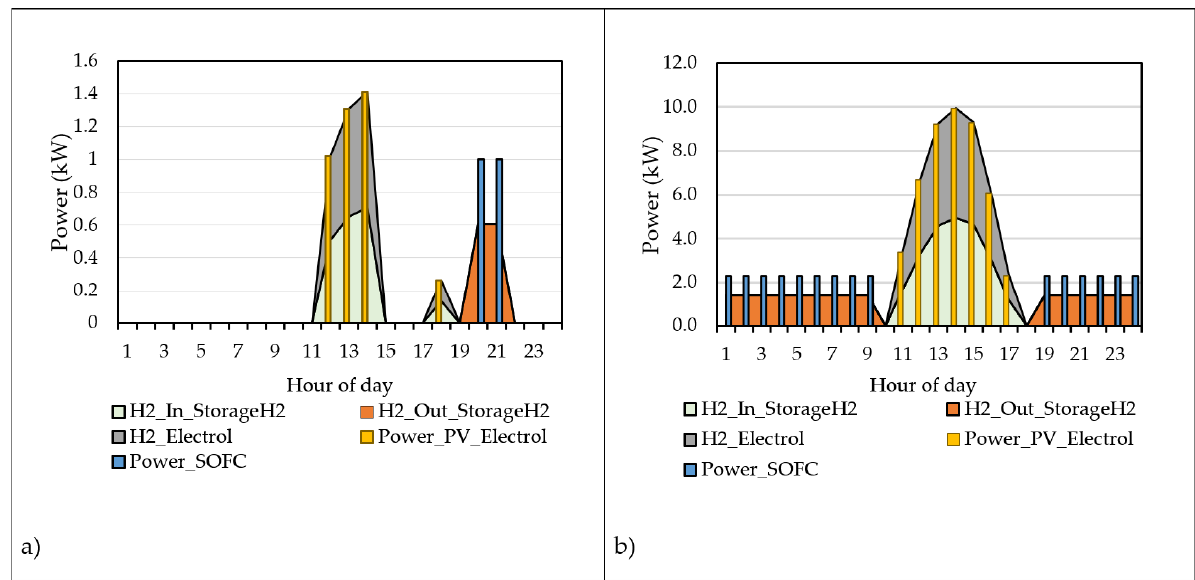
Figure 7. Hourly operation strategies of the r-SOC in the MES configurations in an intermediate day of the winter season for ( a ) economic optimization and ( b ) energetic optimization.